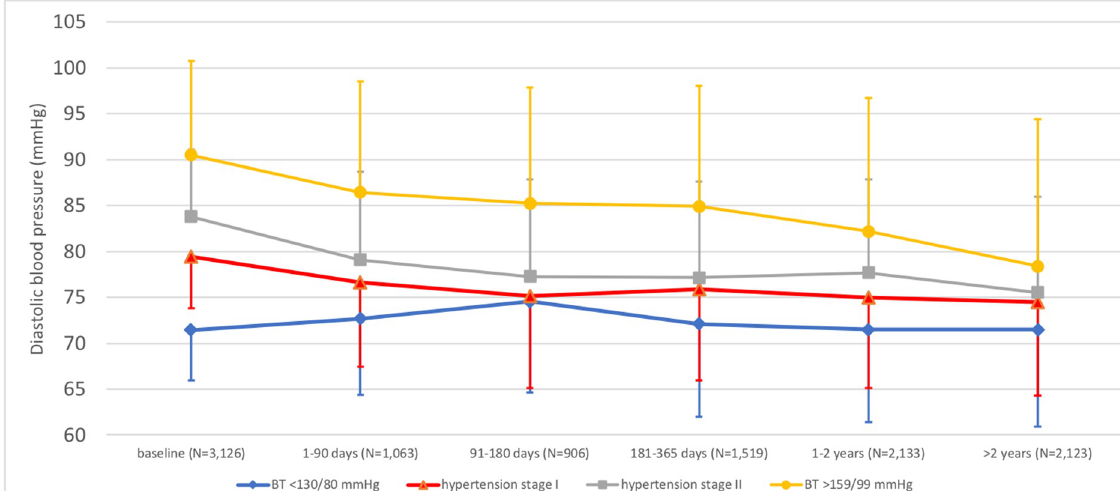
Fig 6. Changes in diastolic blood pressure after the baseline examination in Healthy Ageing Initiative (HAI) participants, based on blood pressure category at baseline. The figure is based on a total of 7,744 follow-up measurements in 3,126 HAI participants. Means and standard deviations are presented. Hypertension stage 1: systolic blood pressure of 130–139 mm Hg or diastolic blood pressure of 80–89 mm Hg. Hypertension stage 2: systolic blood pressure of � 140 mm Hg or diastolic blood pressure of � 90 mm Hg. BT, blood pressure.